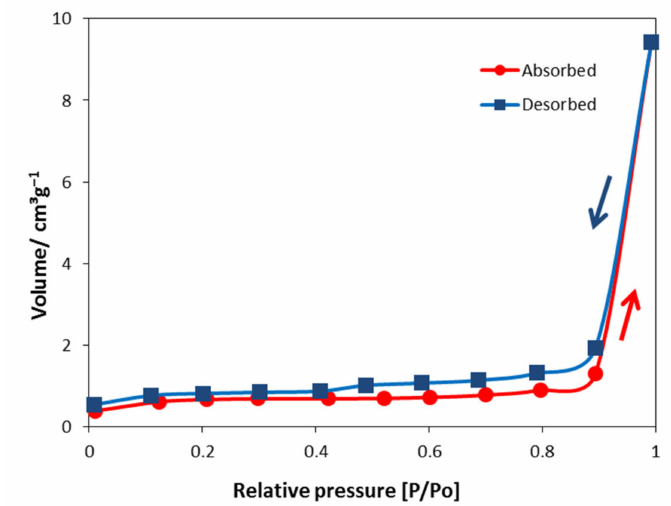
Figure 2. Adsorption–desorption isotherm curve of BCR.